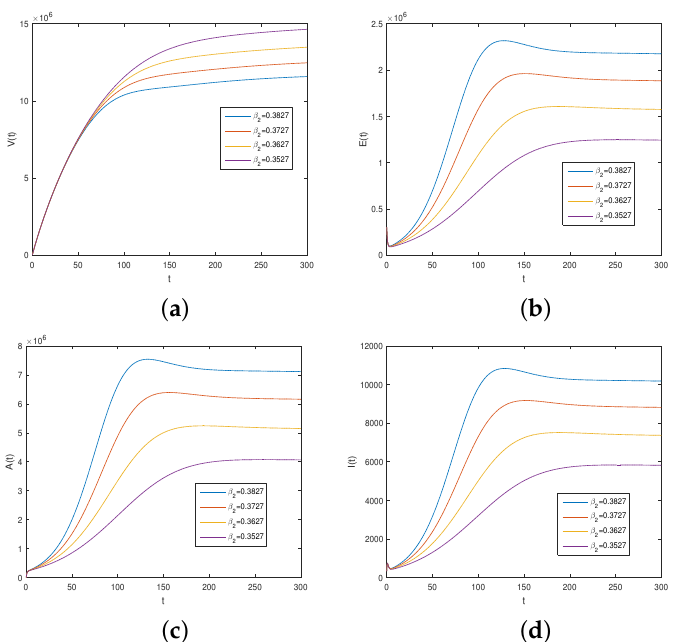
Figure 4. Simulation of the model components for different values of δ and η = 0.95. Subfigures ( a – d ) describe the dynamics of vaccinated, exposed, asymptomatic, and symptomatic individuals respectively.